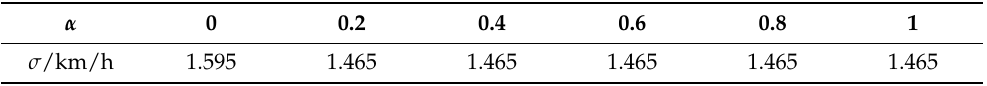
Figure 19. Comparing the speed of the motor with the compensable coefficient under different working conditions A. ( a ) α = 0; ( b ) α = 0.2; ( c ) α = 0.4; ( d ) α = 0.6; ( e ) α = 0.8; ( f ) α = 1. Table 6. The standard deviation of the vehicle speed corresponding to the compensable coefficient for different motors under working condition B.